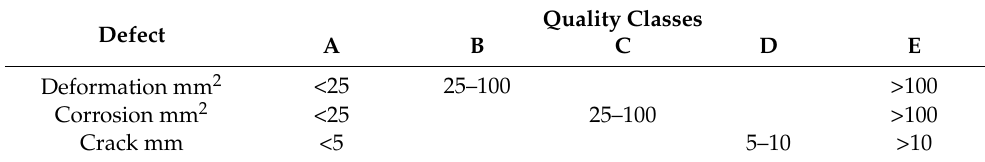
Table 5. Proposed quality